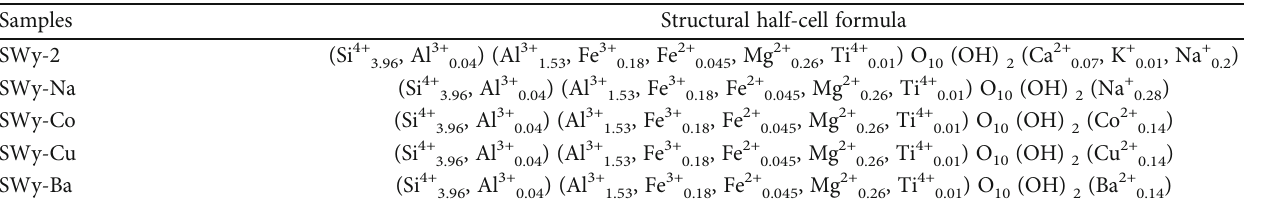
Table 3: Examples of half-cell structural formulas for raw montmorillonite SWy-2 and exchanged (SWy-2) with sodium and heavy metals at full saturation.